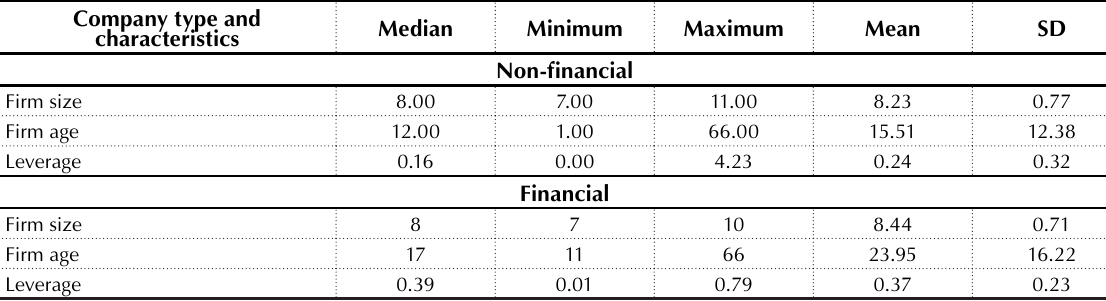
Table 2. Descriptive statistics for the control variables Company type and characteristics